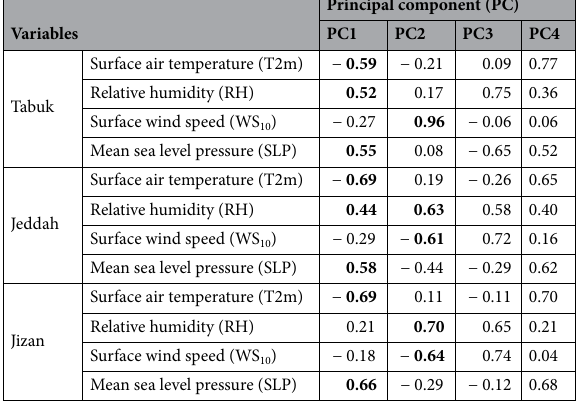
Table 4. Principal component analysis of Tabuk, Jeddah and Jizan based on the corrected ERA5 parameters. The bold numbers indicate highly significant correlations above 0.40.